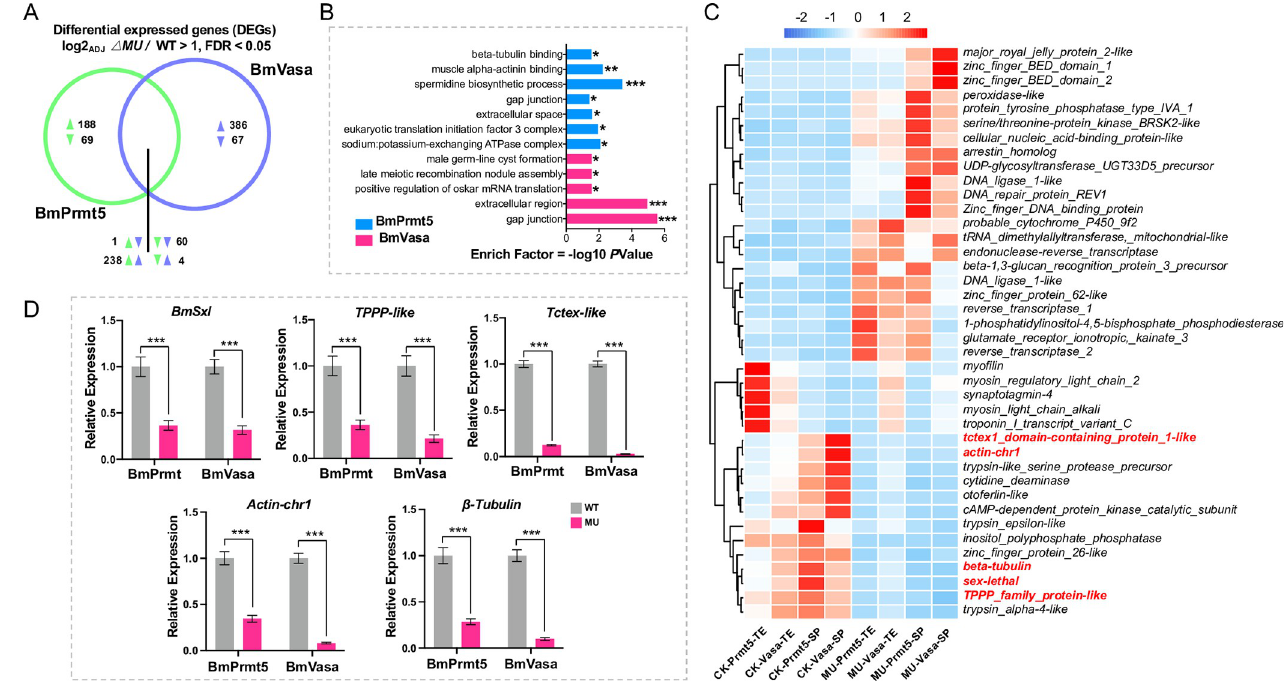
Fig 6. BmPrmt5 and BmVasa co-regulate many spermatogenesis-related genes. (A) Venn diagram of numbers of sperm-specific genes commonly and specifically regulated by BmPrmt5 (left, green) and BmVasa (right, purple) relative to WT. (B) GO enrichment analysis of the biological processes associated with the sperm-specific genes regulated by BmPrmt5 and BmVasa. � P � 0.05; �� P � 0.01; ��� P � 0.001. (C) Hierarchical clustering of selected spermatogenesis-related DEGs in different samples. CK-Prmt5, control for BmPrmt5 mutants; CK-Vasa, control for BmVasa mutants; MU-Prmt5, BmPrmt5 mutants; MU-Vasa, BmVasa mutants; TE, testis; SP, sperm. (D) qRT-PCR analysis of the selected spermatogenesis-related DEGs regulated by BmPrmt5 and BmVasa. Data are means ± SEM (n = 3, ��� P < 0.001, two-tailed Student’s t-test). Δ BmPrmt5 and Δ BmVasa represent BmPrmt5 and BmVasa mutants,